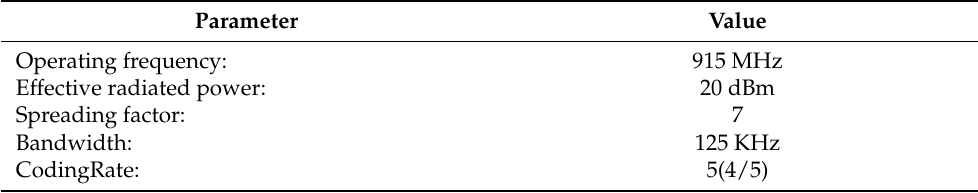
Table 1. Device configuration parameters used.